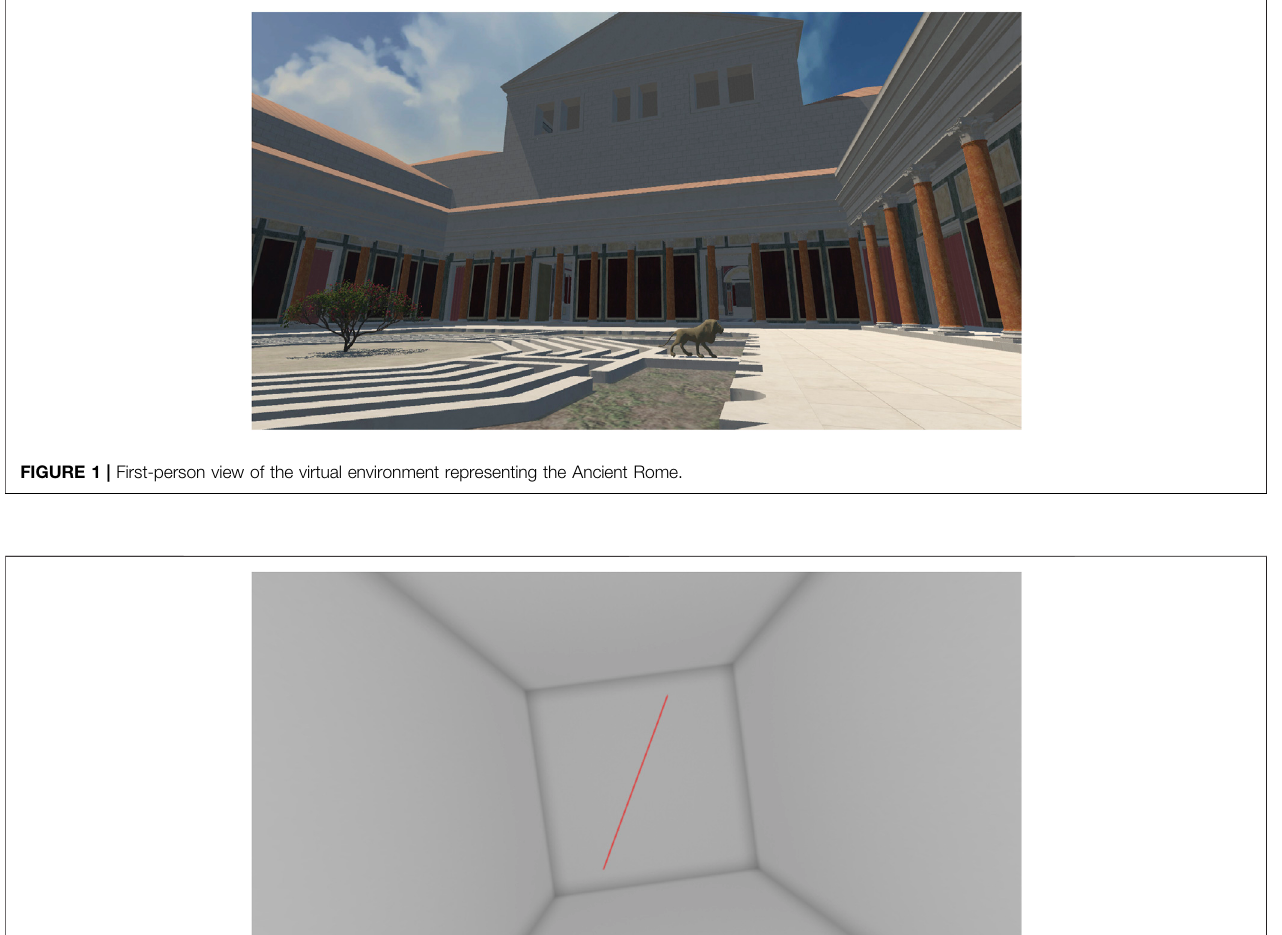
Frontiers in Virtual Reality |